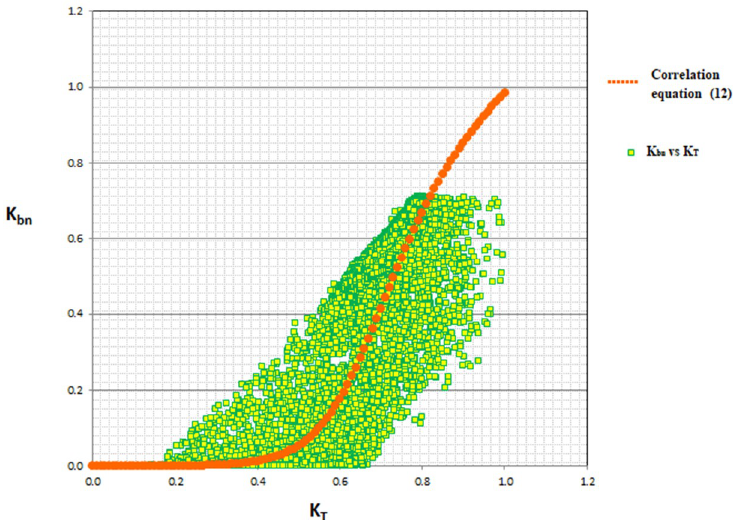
Figure 7. Dispersion graph of hourly parameter pairs ( K T , K bn ), where K T is global transmission coefficient and K bn is the transmission coefficient for normal direct radiation with their correlation Equation (12) (in red).